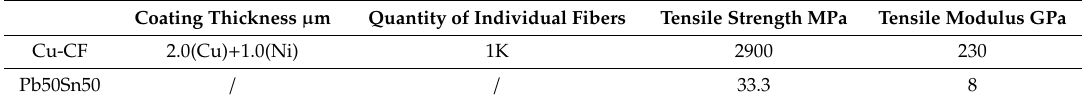
Table 1. Properties of materials.